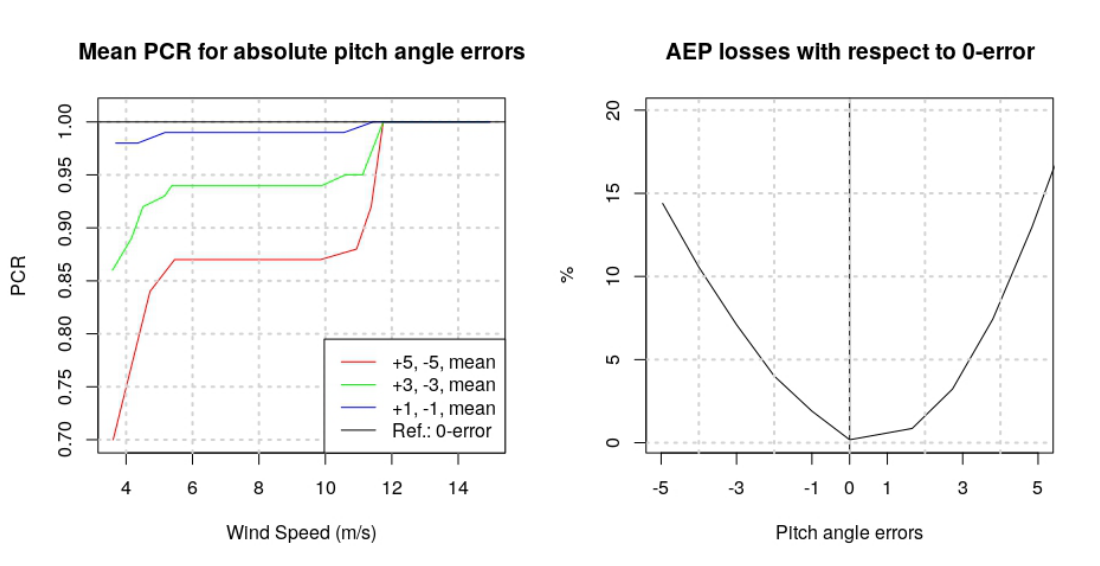
Figure 4. Steady-state Power Curve Ratio ( PCR ) and annual energy production ( AEP )